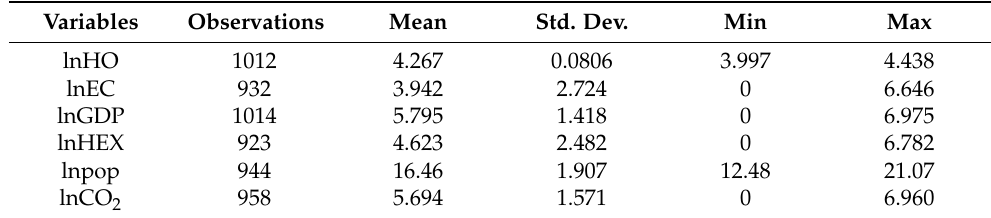
Table 2. Summary